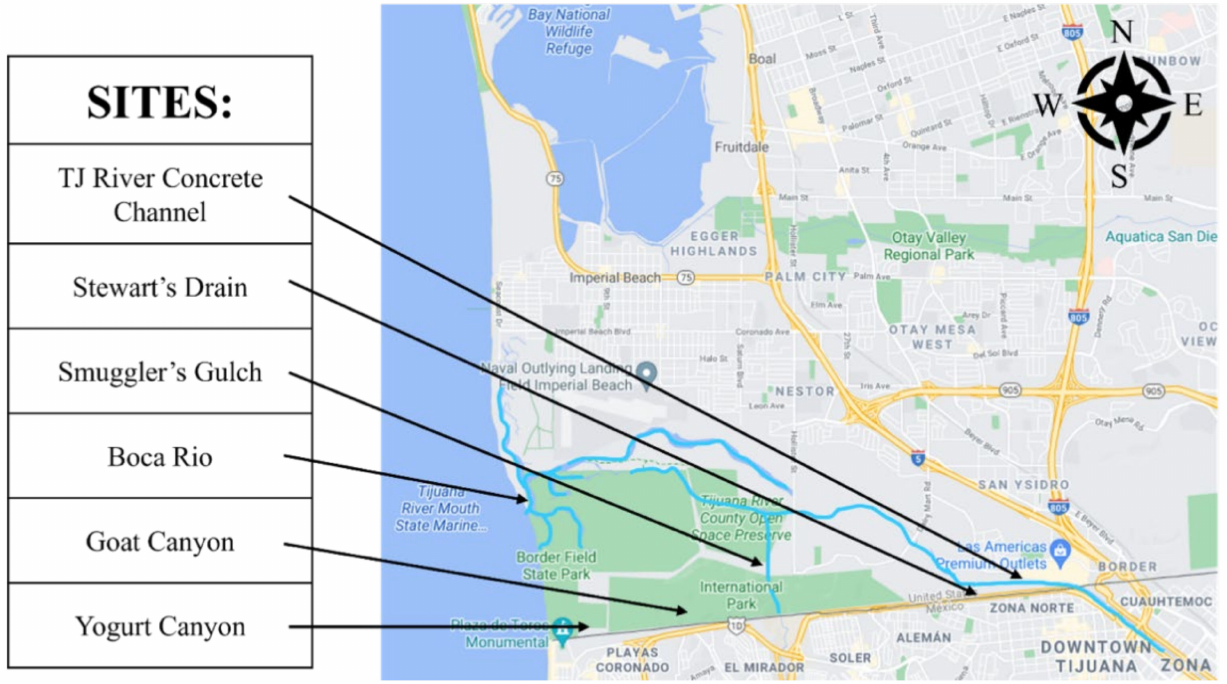
Figure 1. Location of sampling sites, November 2019–February